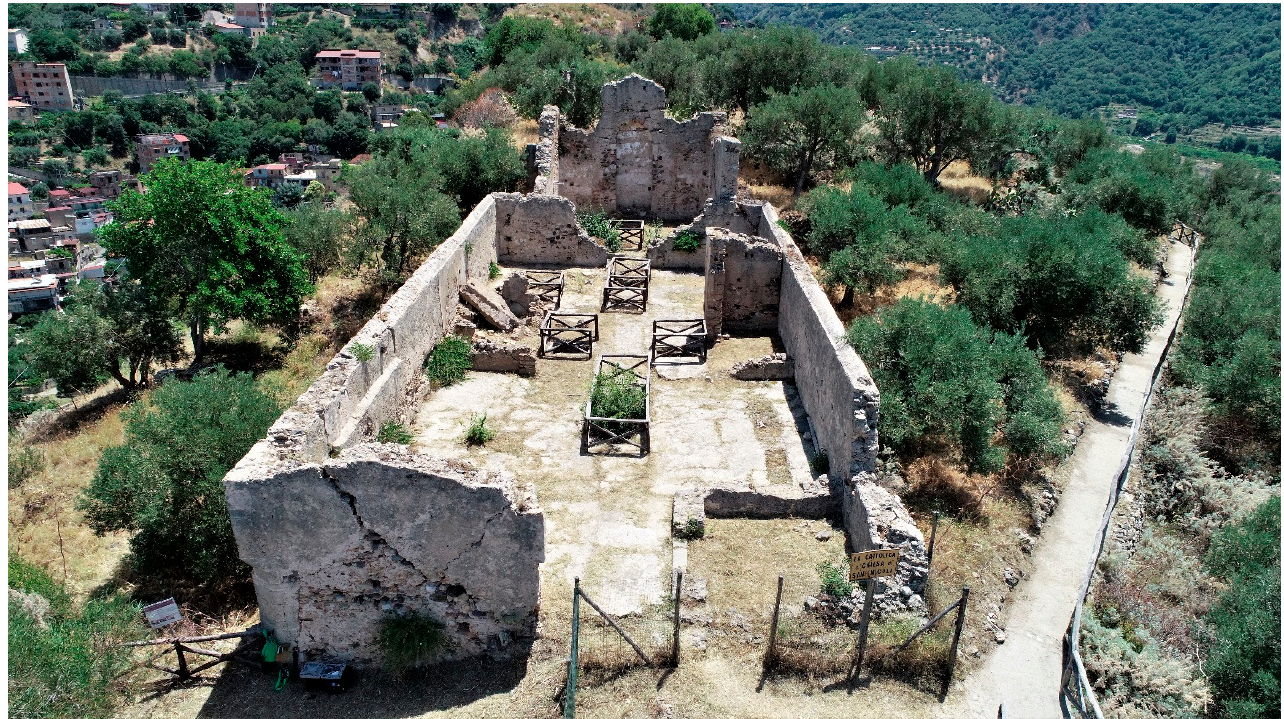
Figure 4. Aerial view of the church of San Nicola from the west.